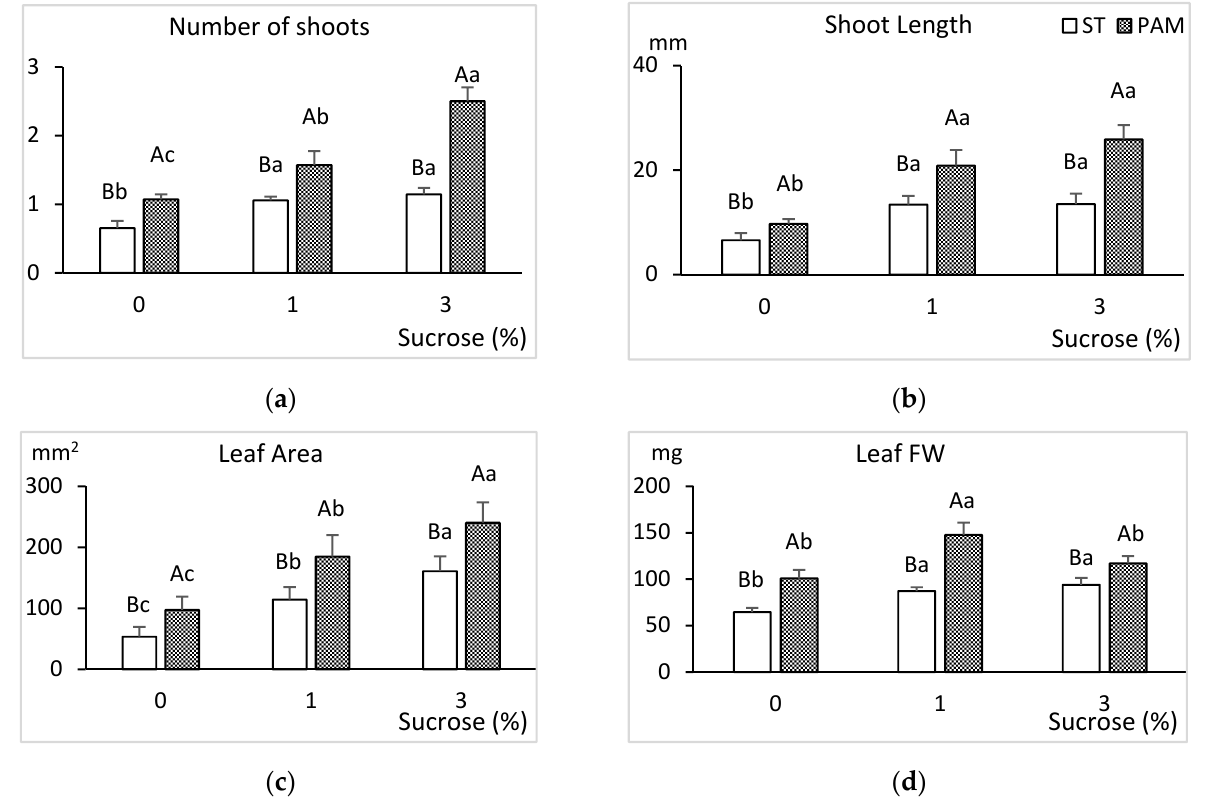
Figure 6. Effect of growth conditions and sucrose supplementation on the growth of the genotype CBP cultured in RITA© with 6 immersions/day. ( a ) Number of shoots, ( b ) shoot length (mm), ( c ) leaf area and ( d ) leaf biomass. Different uppercase letters indicate significant differences in relation to the growth conditions, and different lowercase letters indicate significant differences in relation to the sucrose supplementation ( p < 0.05). ST: standard conditions, PAM: photoautotrophic conditions and FW: fresh